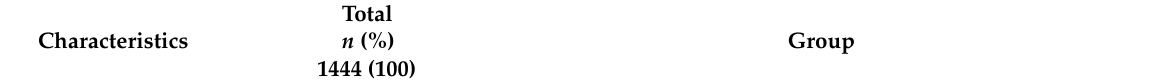
Table 1. The demographics of the patients ( n =